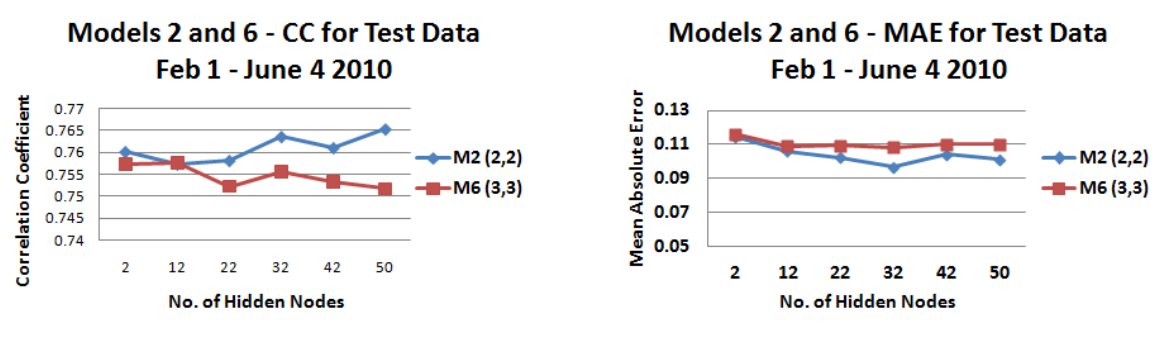
and 6 (3,3) when tested on data from 1 February to 4 June 2009—( a ) Correlation Values ( b ) Error Values.